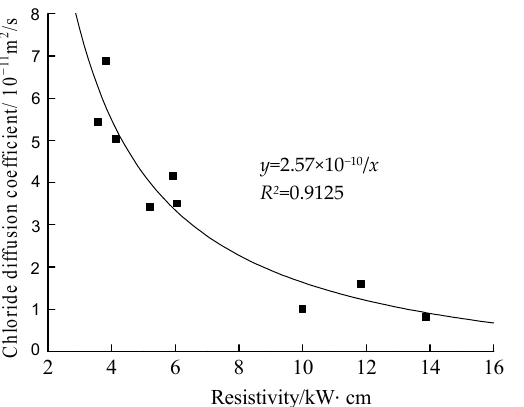
Figure 17. Relationship between chloride diffusion coefficient and resistivity of concrete.